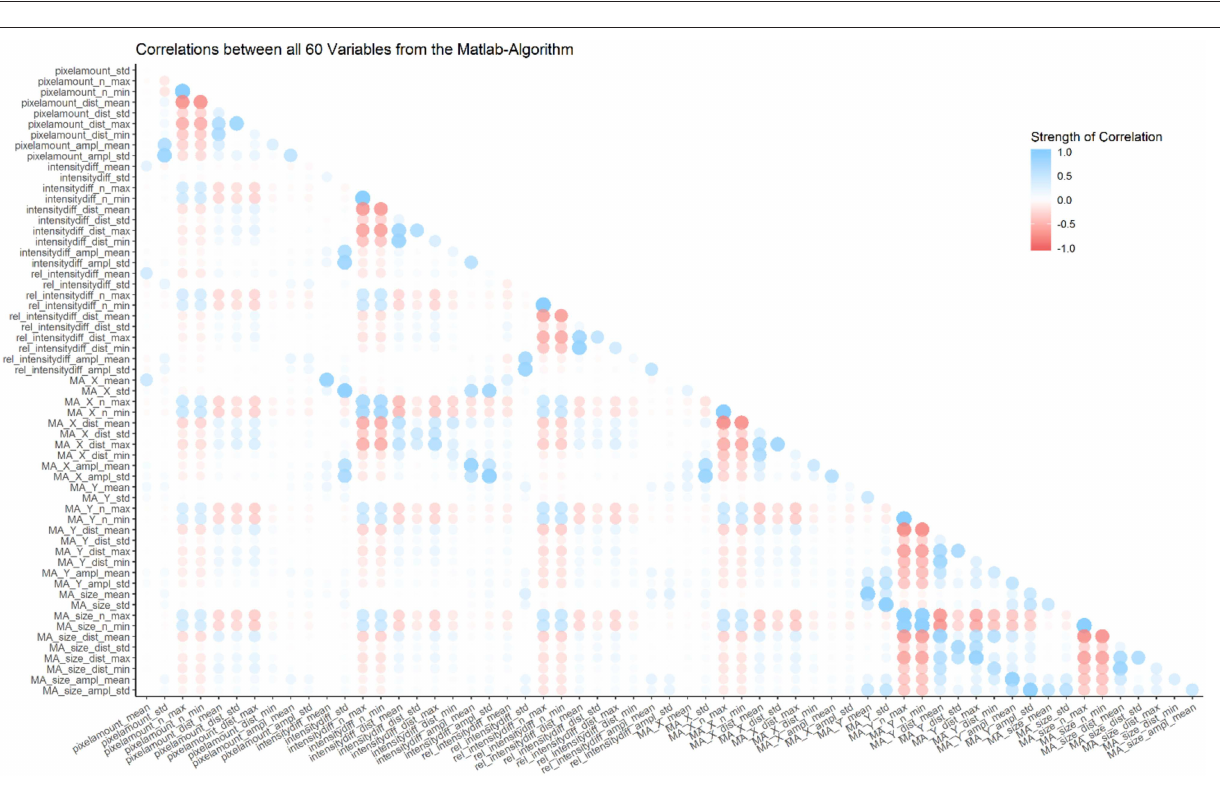
FIGURE 4 | Overview of correlations between all 60 variables from the MATLAB algorithm. Most correlations are weak, but some parameters are inherently connected, and thus show strong correlations (e.g., number of minima and number of maxima in the same category). eight clips for each of the four different possible combinations rates for actions and emotions (see section Homogenizing for (two actions × two emotions; see Figures 1B–D for an overview Recognition Rates). The procedure comprises three selection of the selection steps, which lead to a highly homogenous set of 32 stimuli with